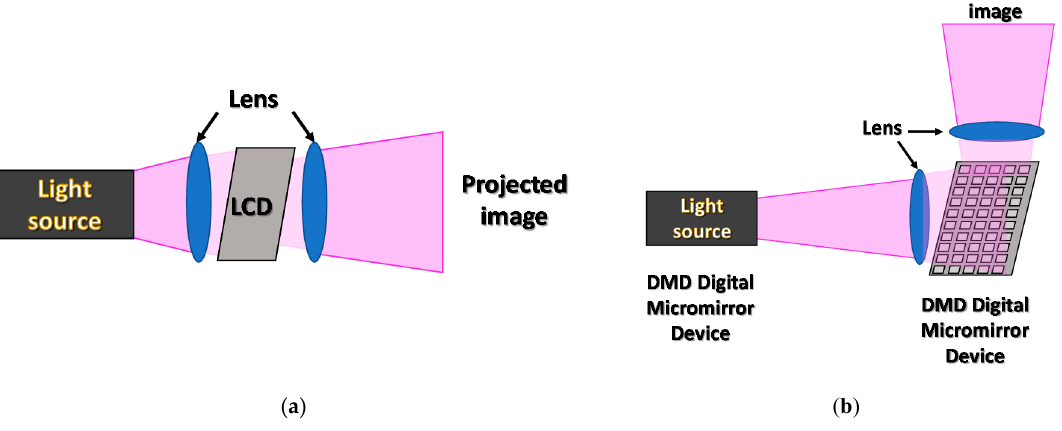
Figure 4. Principle of operation for ( a ) LCD and ( b ) DMD type projectors.